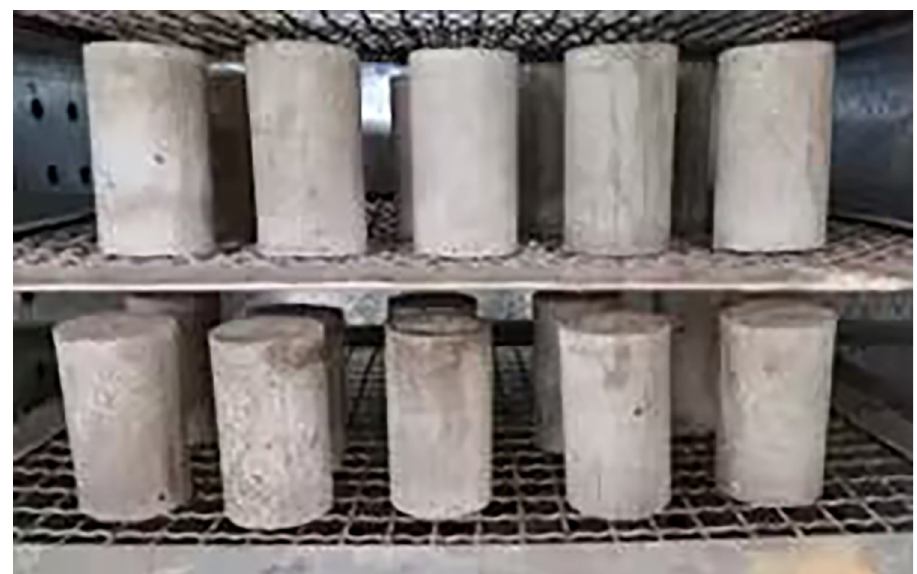
Fig 10. Maintenance of the specimens covered by the